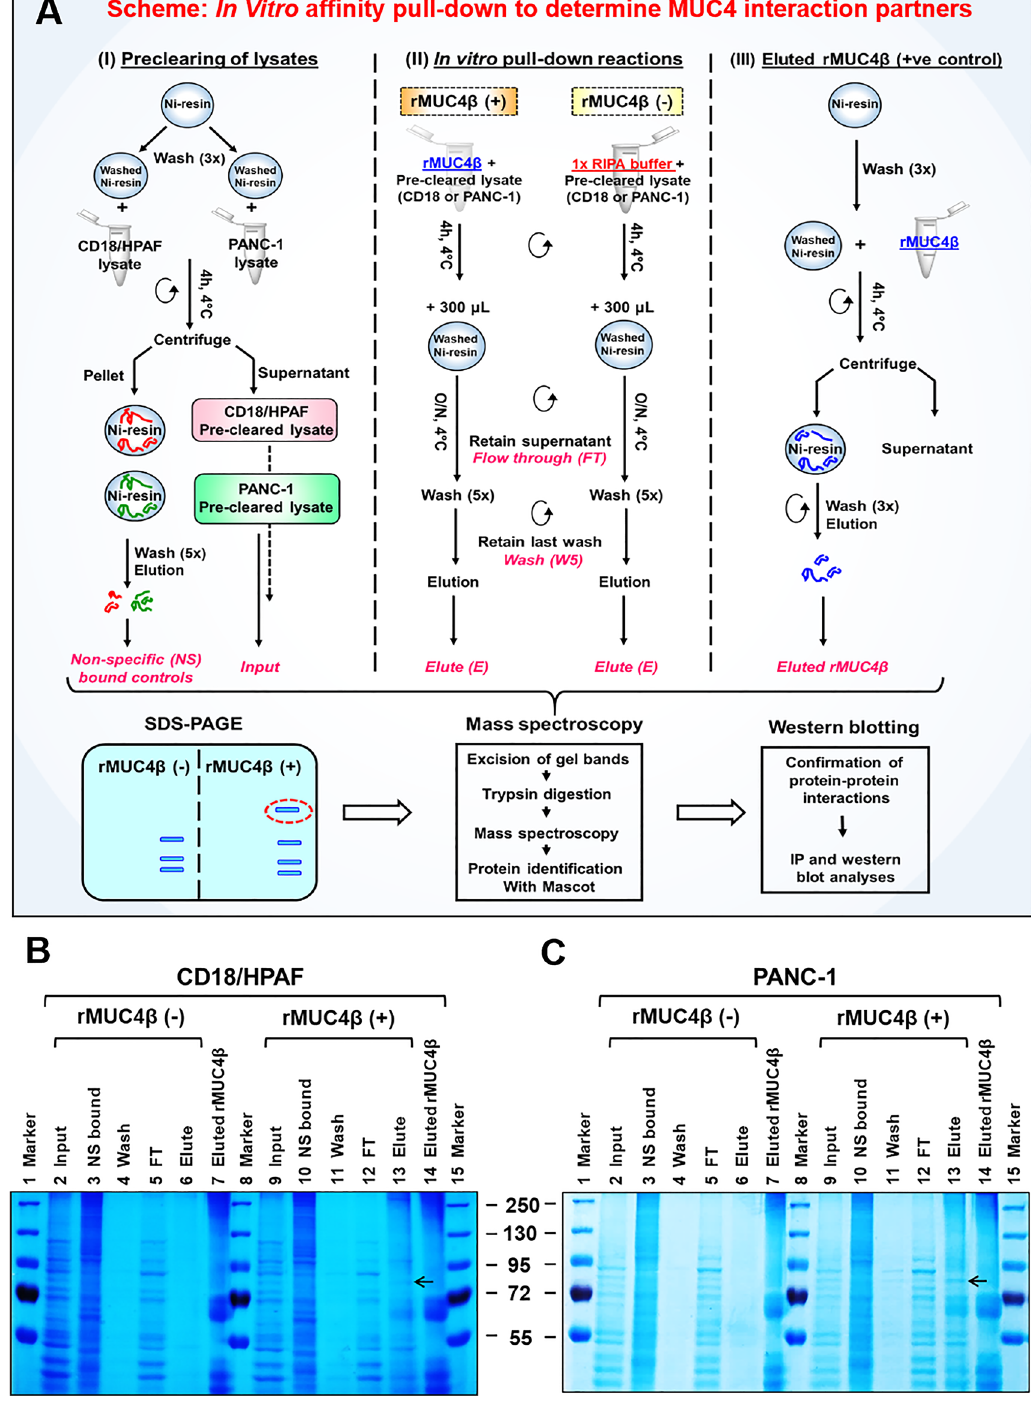
Figure 3. Affinity pull-down and tandem mass spectrometry to determine the interacting partners of MUC4. ( A ) Schematic outline of affinity pull-down assays (I) Pre-clearing of total lysate [input] of MUC4 expressing (CD18/HPAF) and non-expressing (PANC-1) pancreatic cancer cell lines. (II) Affinity pull-down reactions were performed in the presence [rMUC4β (+)] or absence [rMUC4β (−), i.e., RIPA buffer] of rMUC4β (bait) added with washed Ni–NTA beads. Respective supernatants [i.e., Flow-through (FT) and last wash (W5)] were collected before the final elution. (III) An aliquot of rMUC4β-bound Ni-resin was eluted separately to serve as a positive control. All saved fractions (as shown in pink color, italic font) from CD18/HPAF ( B ) and PANC1 ( C ) were resolved on SDS-PAGE gel and stained with Coomassie Blue. The ~ 80 kDa band (arrowed) was identified, excised, and assessed by the tandem MS/MS and proteomic